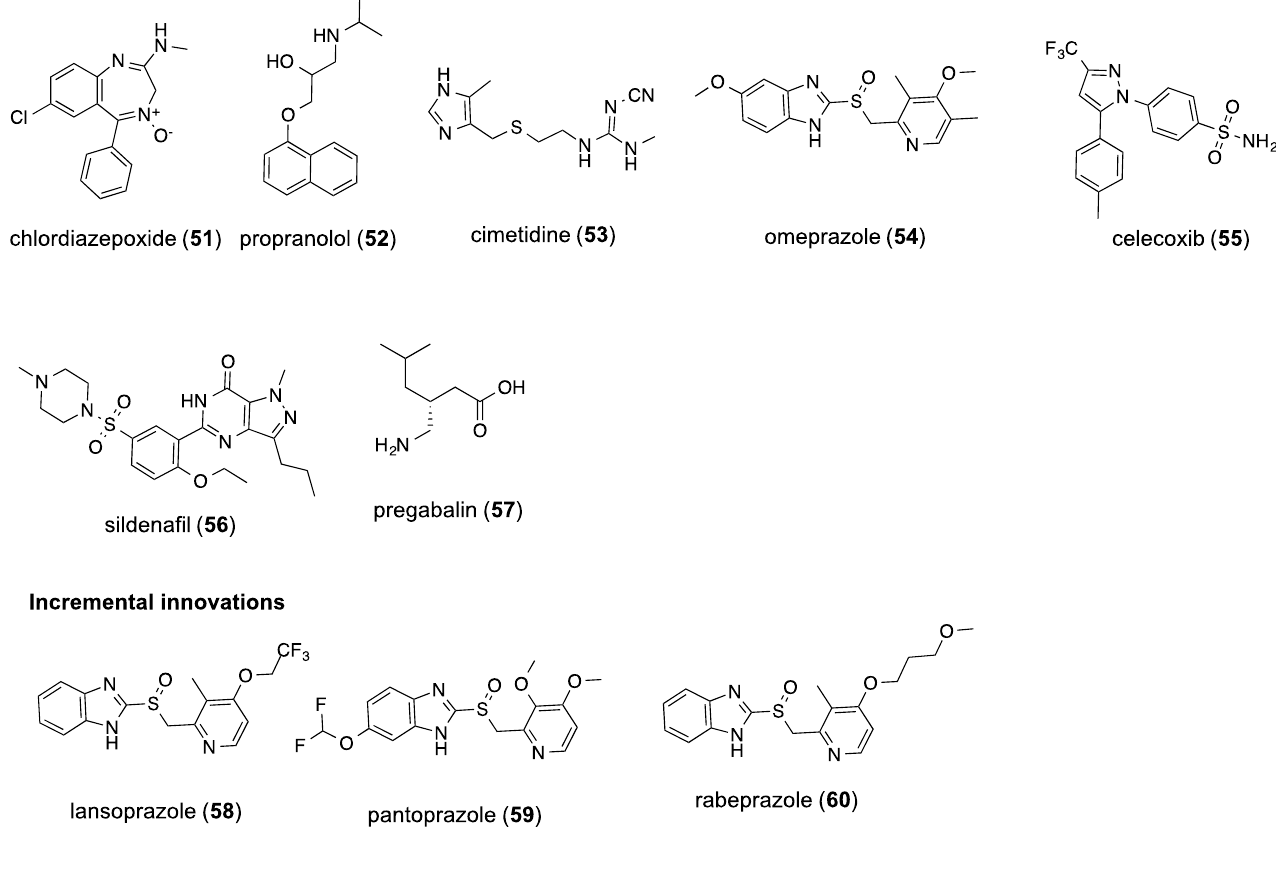
FIGURE 6 - Examples of drugs developed through radical (51-57) and incremental (58-60)